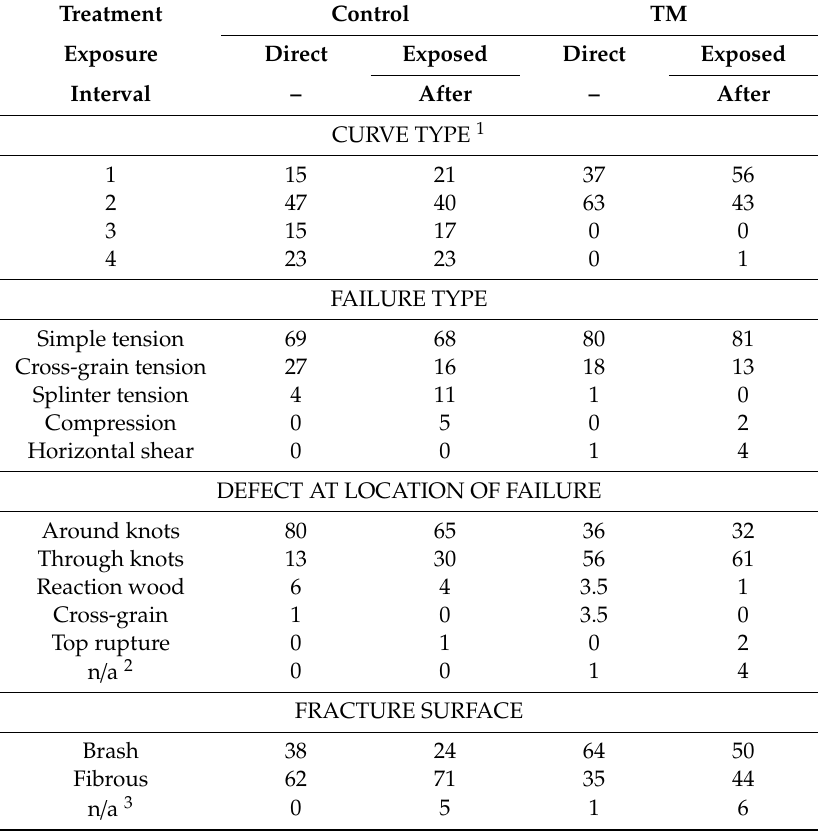
Figure 10. Work-to-maximum load (WML) of control (left y -axis / circles) and TM boards (right Figure 10. Work ‐ to ‐ maximum load (WML) of control (left y ‐ axis/circles) and TM boards (right y ‐ y -axis / squares) tested directly and after weathering. axis/squares) tested directly and after weathering. Table 5. Type of load–deflection ( F – w ) curve, and characterisation of failure type, defect and fracture surface at maximum load of control and TM boards tested directly and after exposure (% frequency of